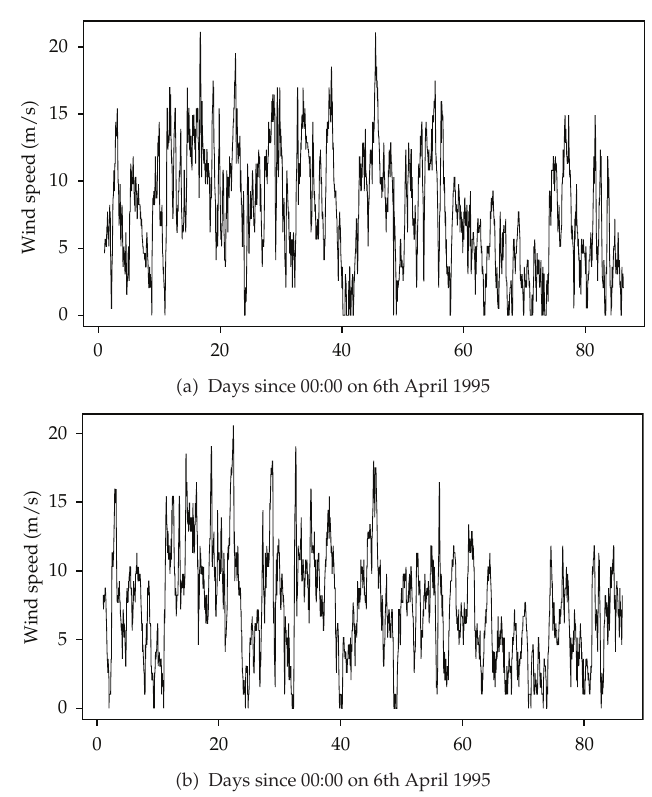
Figure 13: Hourly wind speeds from 00:00 on 6th April 1995: (cid:5) a (cid:6) Aberporth (cid:5) b (cid:6) Valley.